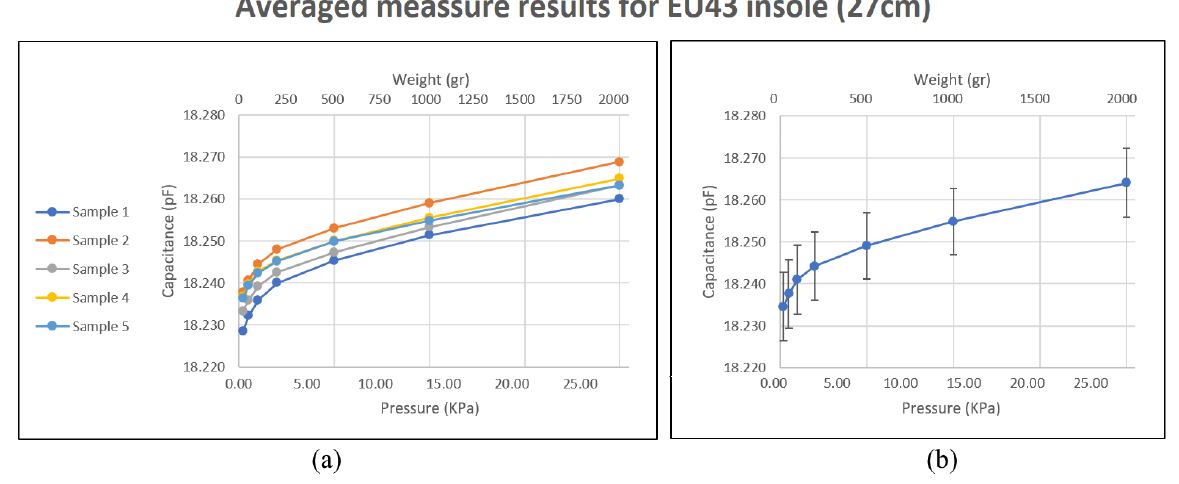
Figure 6. Capacitive plantar insole, size 43 (27 cm). Behavior of sensors against weight in the area they occupy. ( a ) show the average results for each repetition performed. ( b ) shows the combined average of all